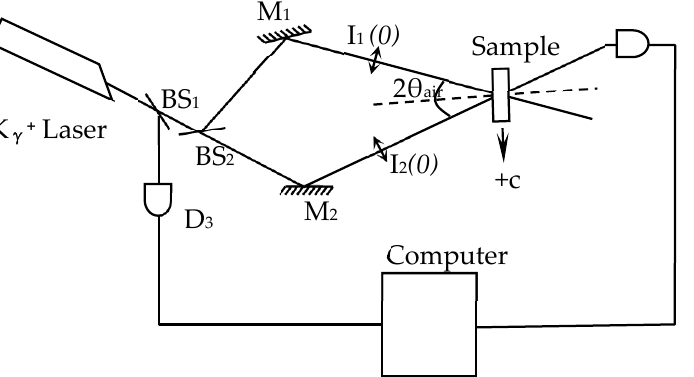
Figure 2. Experimental setup of two-wave coupling. M 1 , M 2 : mirrors; BS 1 , BS 2 : beam splitters; D 1 , D 3 : photo detectors; 𝐼 (cid:2869) (cid:4666)0(cid:4667) : incident signal beam; 𝐼 (cid:2870) (cid:4666)0(cid:4667) : incident pump beam; 𝐼 (cid:2869) (cid:4666)𝛿(cid:4667) : emergent signal beam after coupling.